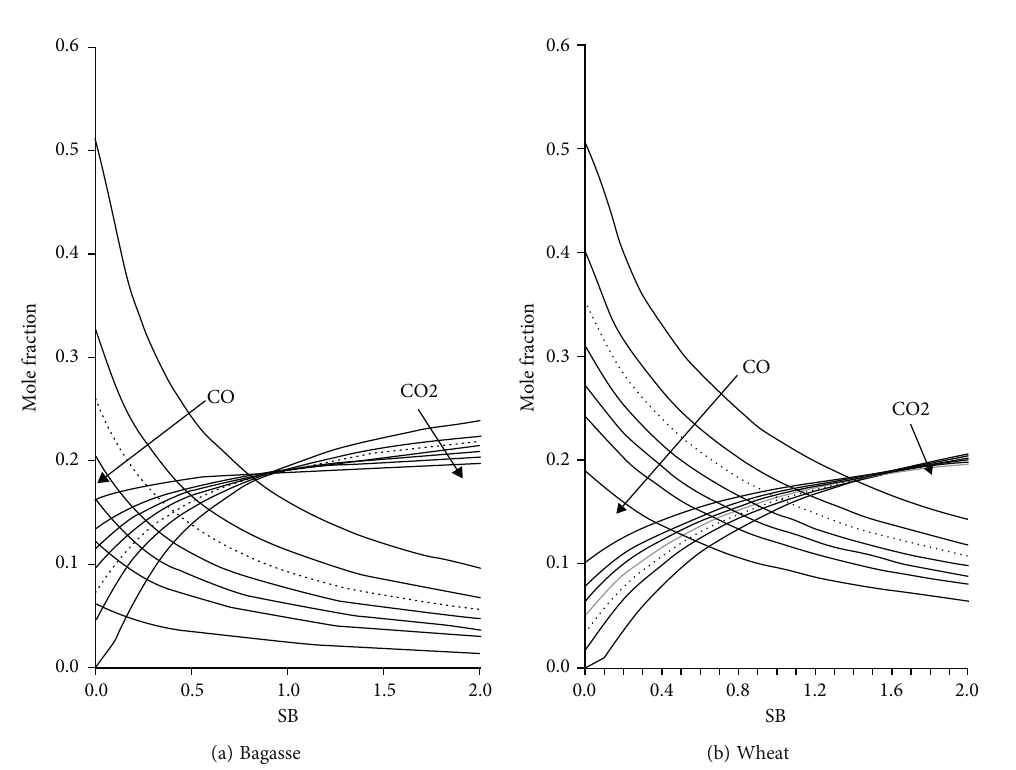
Figure 2: CO and CO concentration vs. ER and SB. Dotted curves at ER = 0 : 15 . The arrow indicates increasing ER. 2